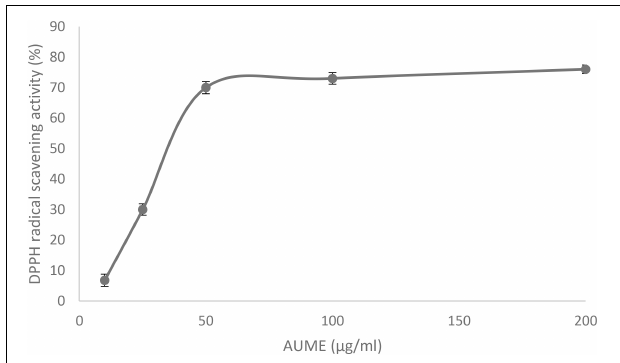
FIGURE 7 | DPPH radical scavenging activity of AUME at different concentrations measured using spectrophotometry. Values are the means ± SD of three replicates, p <